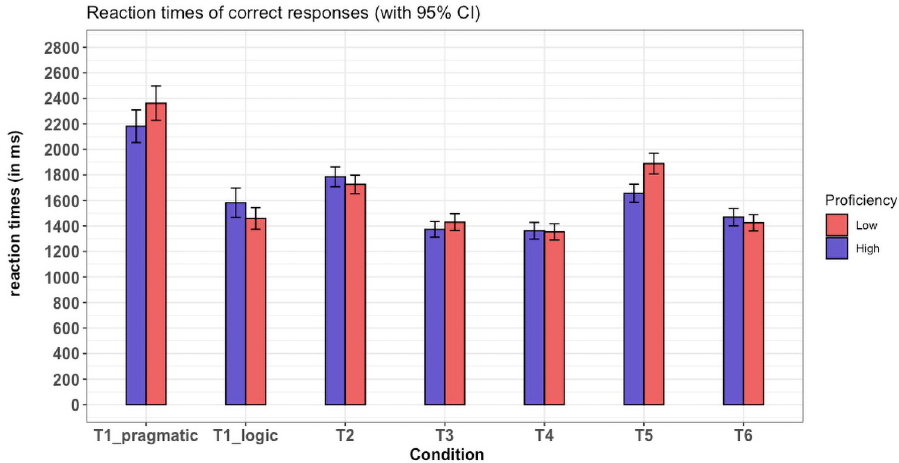
Fig 3. The reaction times as a function of condition (T1-T6) and proficiency (low vs. high). Error bars show confidence intervals.